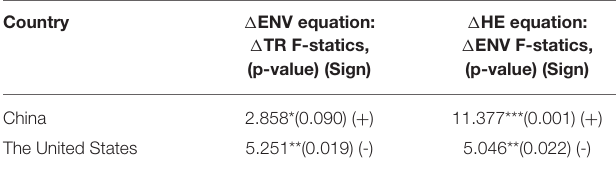
TABLE 4 | The Results in granger causality in short